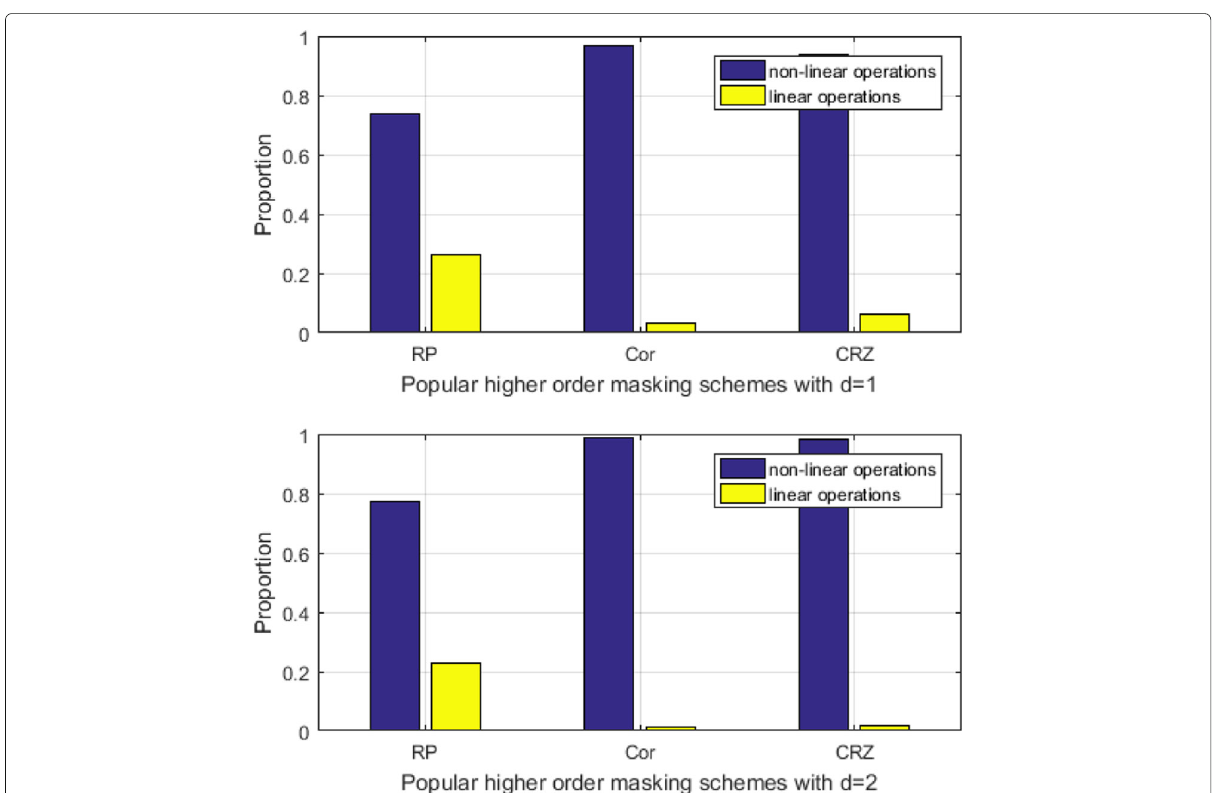
Fig. 2 Running time proportion of non-linear and linear operations in AES higher order masking schemes